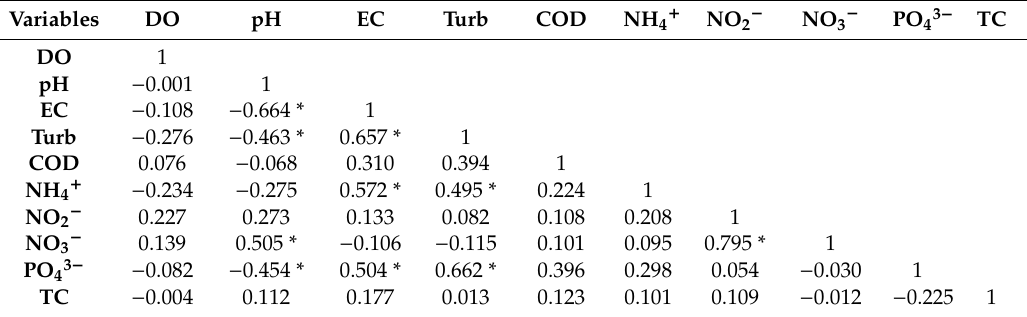
Table 2. Correlation matrices in the dry season using Spearman rank order.